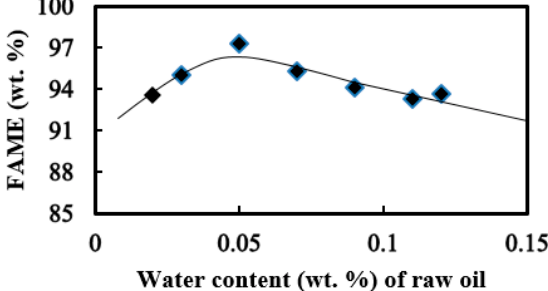
Figure 2. Effects of added water content in palm oil on the fatty acid methyl esters. Figure 2. E ff ects of added water content in palm oil on the fatty acid methyl